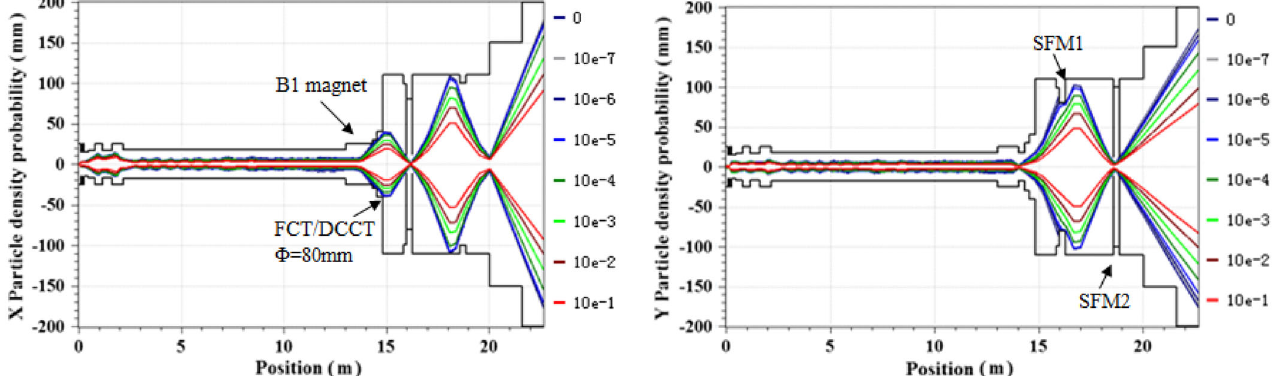
FIG. 29. The transverse particle density level with rf errors and misalignments of the Injector I test stand in the x plane (left) and the y plane (right) from the exit of RFQ to the entrance of the 10 MeV beam dump.